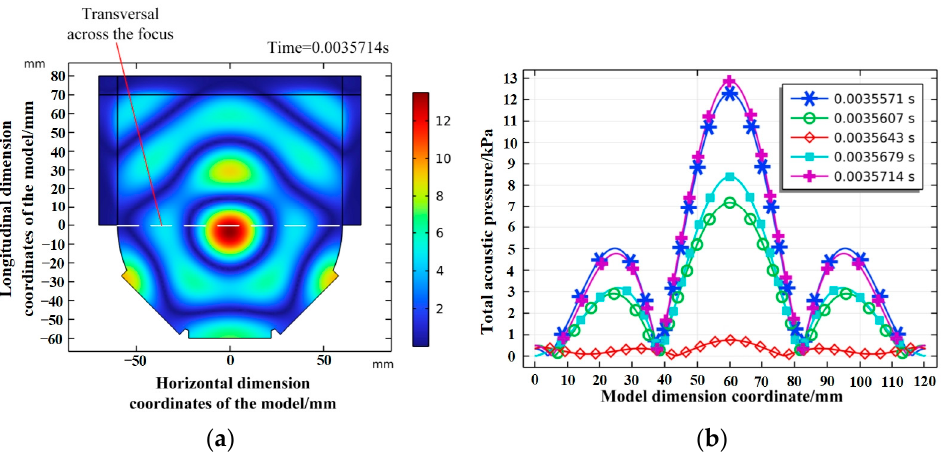
Figure 3. The pressure distribution of the focused ultrasonic field. ( a ) Stable focus - moment ultra- sonic field. ( b ) Acoustic pressure distribution across focal